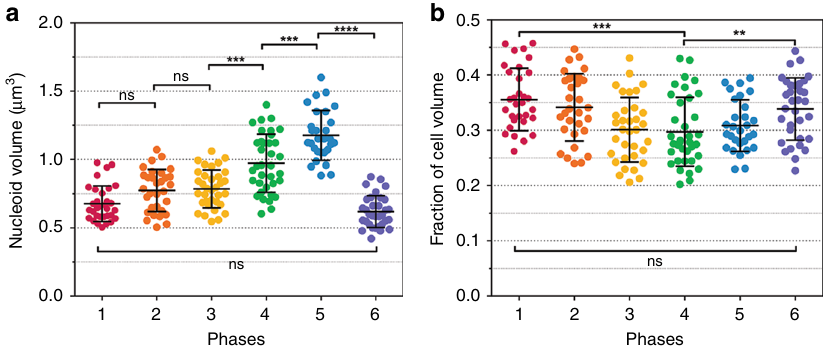
Fig. 4 Nucleoid compaction as a function of D. radiodurans cell cycle. a Changes in nucleoid volume as cells progress through their cell cycle. Nucleoid volumes were retrieved from the three-dimensional signal of Syto9-labelled nucleoids of live, exponentially growing D. radiodurans cells. The nucleoid volume is relatively constant during the fi rst three phases ( ~ 0.7 μ m 3 ) and then progressively increases to reach a maximal volume of ~ 1.2 μ m 3 in Phase 5 cells just before cytokinesis. b The fraction of the cell volume occupied by the nucleoid was retrieved by dividing the nucleoid volume of individual cells by their matched cell volume, derived from spinning-disk images of dual-labelled Syto9- and Nile Red-stained cells, using the cell measurements presented in Supplementary Fig. 2. The fraction of the cell occupied by the nucleoid signi fi cantly decreases during the fi rst three phases (from 0.35 to 0.30), and then remains around 0.30 until cytokinesis. After septal closure, the fraction increases again to 0.34. a , b Data are represented as mean ± SD ( N = 195, N > 29 for each phase). Individual values are shown as dots. (* P < 0.05, ** P < 0.01, *** P < 0.001, **** P < 0.0001, ns: not signi fi cant, statistical test: